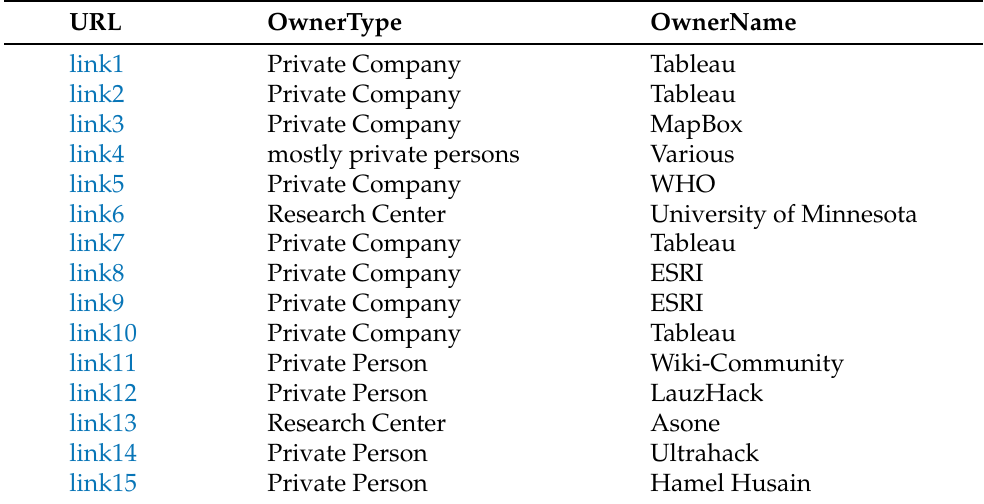
Table A2. A list of collections of